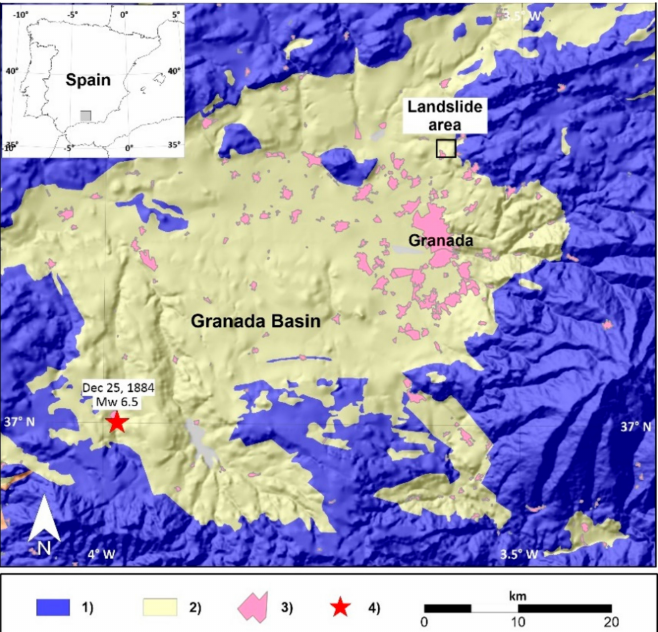
Figure 1. Location map of the study area. ( 1 ) Basin basement, ( 2 ) basin fill (Neogene sedimentary rocks), ( 3 ) urban areas and ( 4 ) location of the 1884 earthquake (Mw 6.5) that reactivated the landslide.